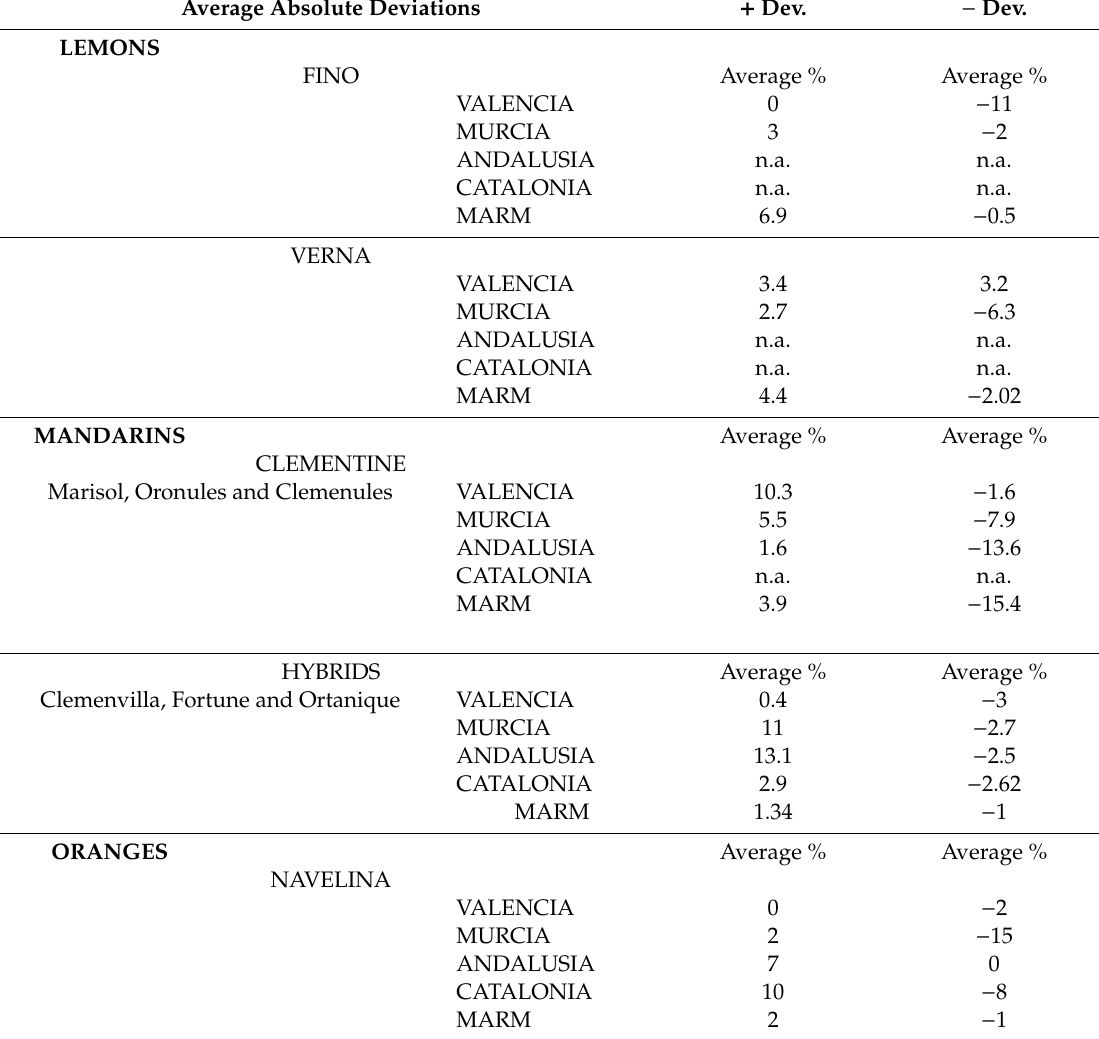
Table 12. Deviations from the average price for the season (lemons, mandarins, and oranges). Average Absolute Deviations + Dev. − Dev. LEMONS FINO Average % Average